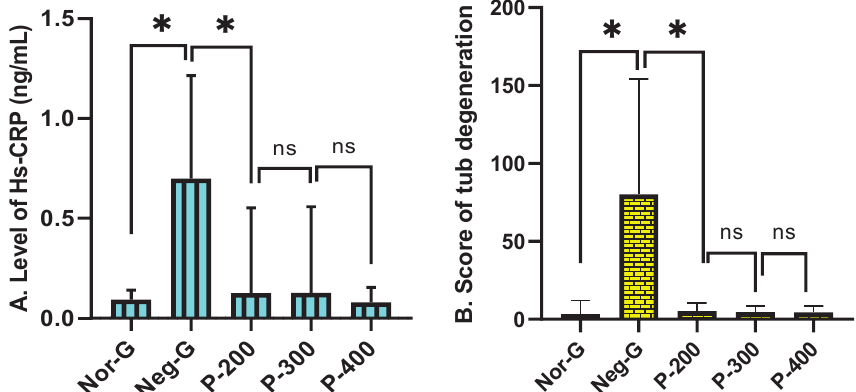
Figure 2. A. Level of hs-CRP; B. Total score of renal tubular degeneration in each group. Post Hoc Analysis p<0.05; ns: not significant